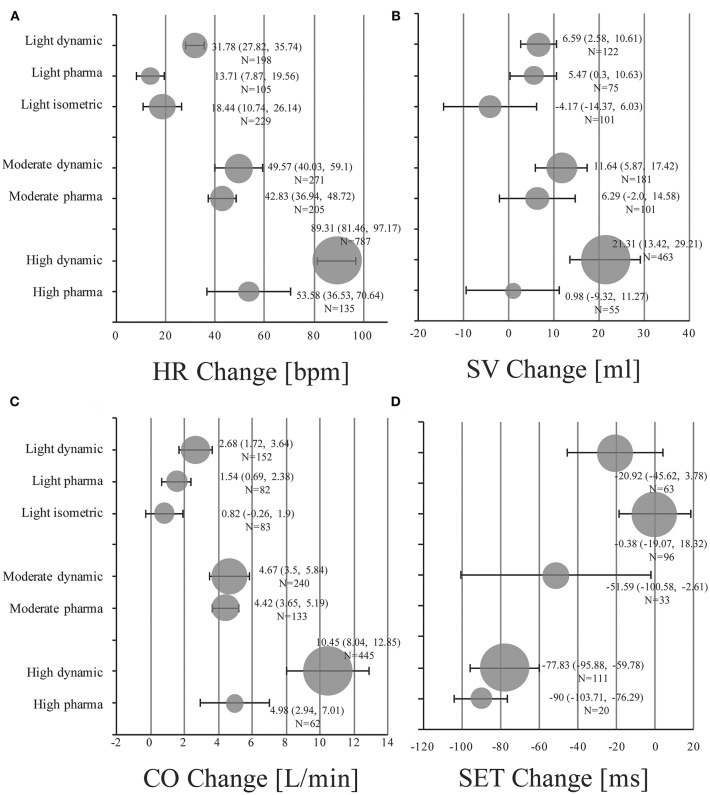
Pooled mean changes and 95% CIs in healthy individuals under stress conditions for (A) HR Change: absolute changes in heart rate in beats per minute (bpm). (B) SV Change: absolute changes in stroke volume in ml. (C) CO Change: absolute changes in cardiac output in liters per minute (l/min). (D) SET Change: absolute changes in systolic ejection time in milliseconds (ms). Bubble size is proportional to the number of stress examinations included (N).